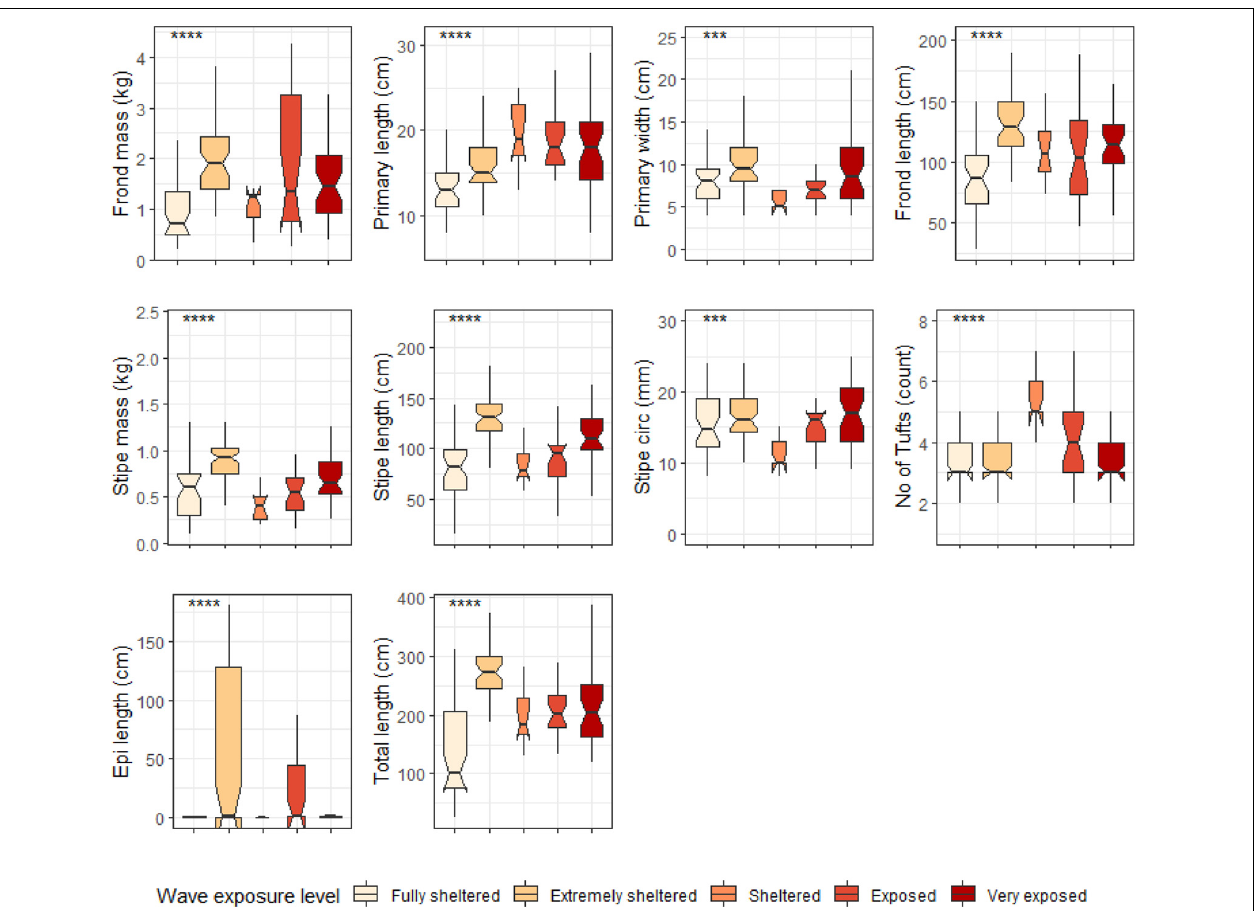
FIGURE 11 | Boxplots representing shallow E. maxima morphological characteristics grouped by wave exposure category measured around the Western Cape coastline, with the y -axis depicting the specific morphology measured, with units provided. The lower and upper hinges correspond to the first and third quartiles. The whiskers represent the range, solid black lines represent the median and black dots are outliers. Significance levels are as follows: * represents ≤ 0.05, ** represents ≤ 0.01, *** represents ≤ 0.001, **** represents ≤